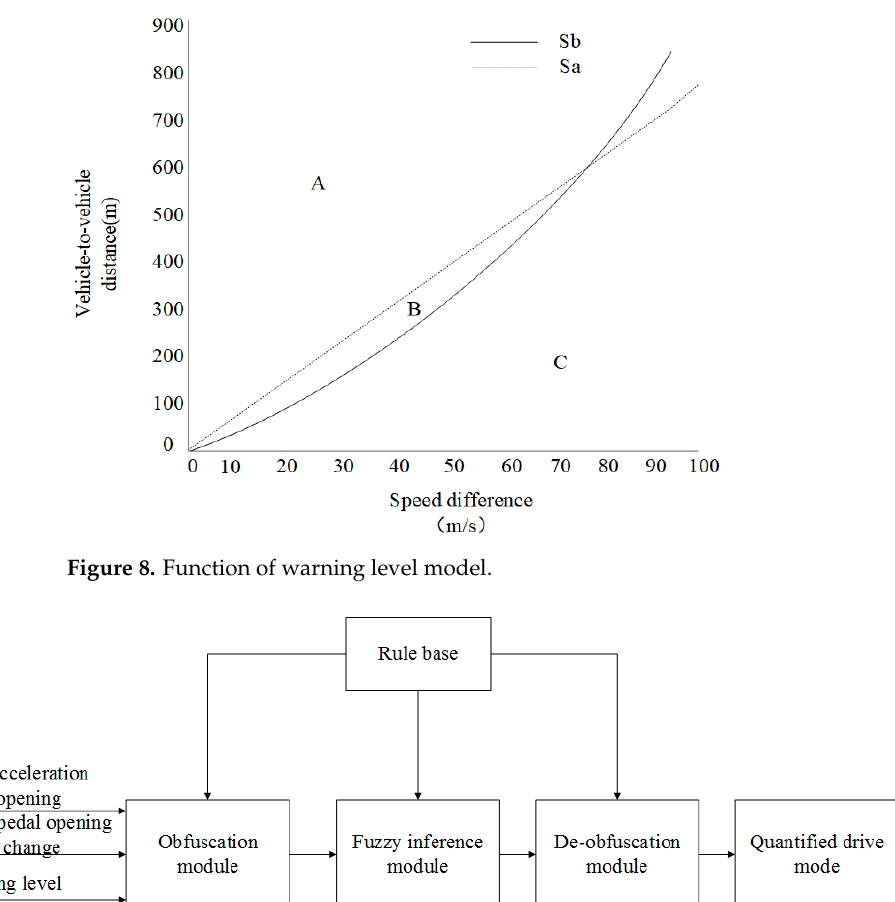
Figure 9. Flow chart of drive mode selection.